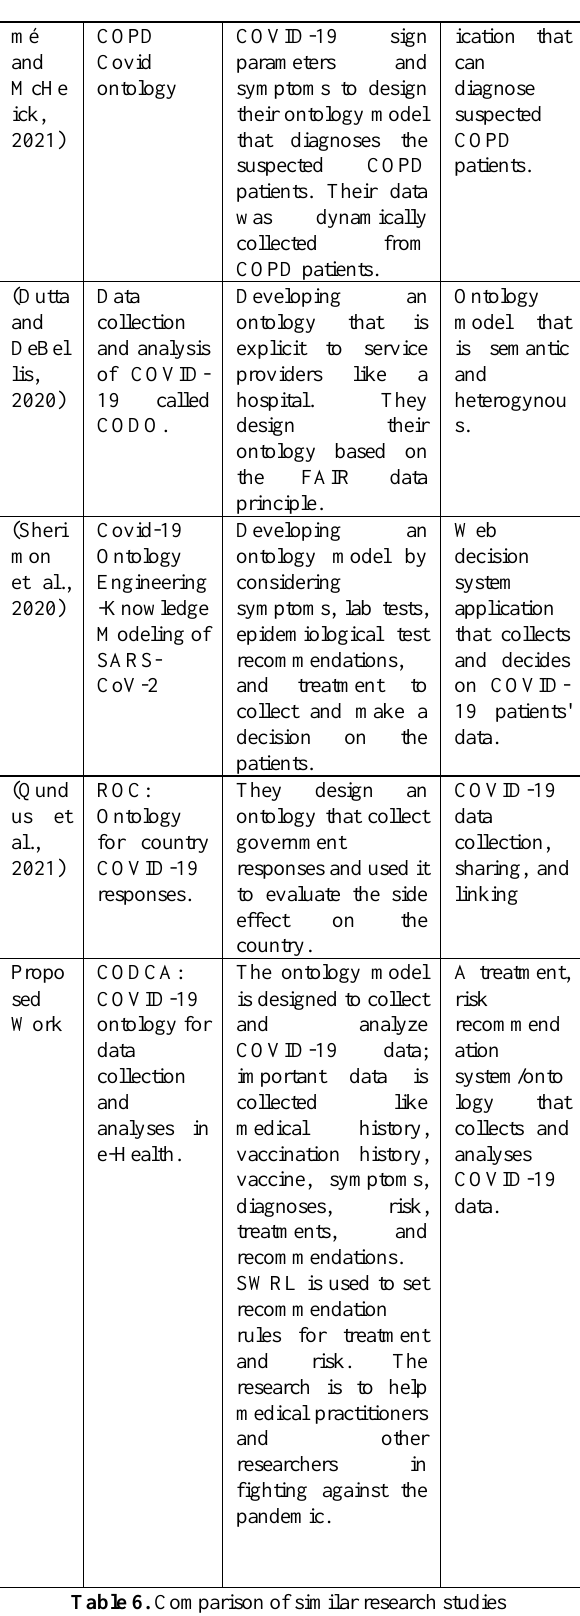
Table 6. Comparison of similar research